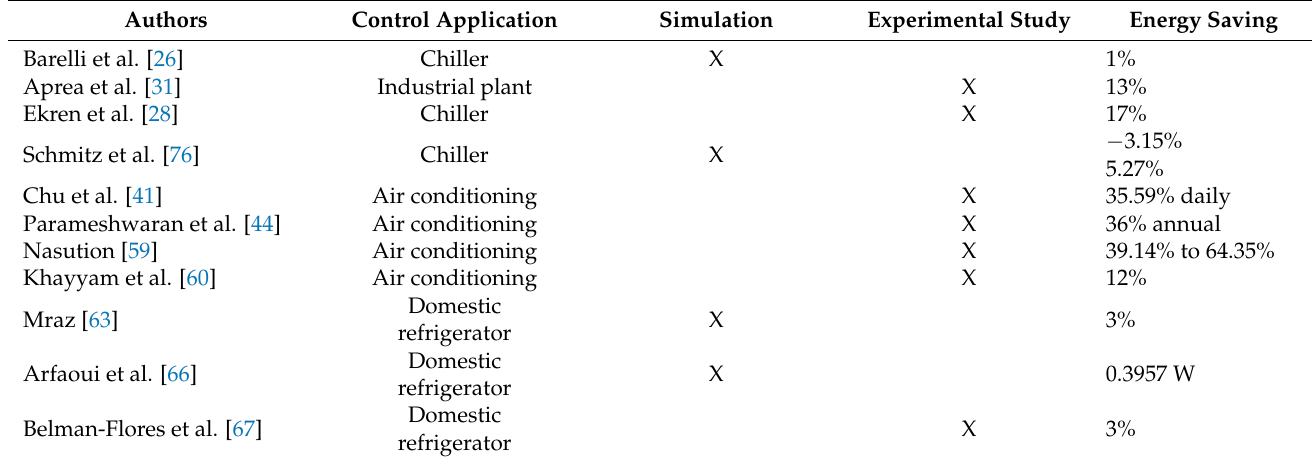
Table 3. Reduction in energy consumption due to the use of fuzzy